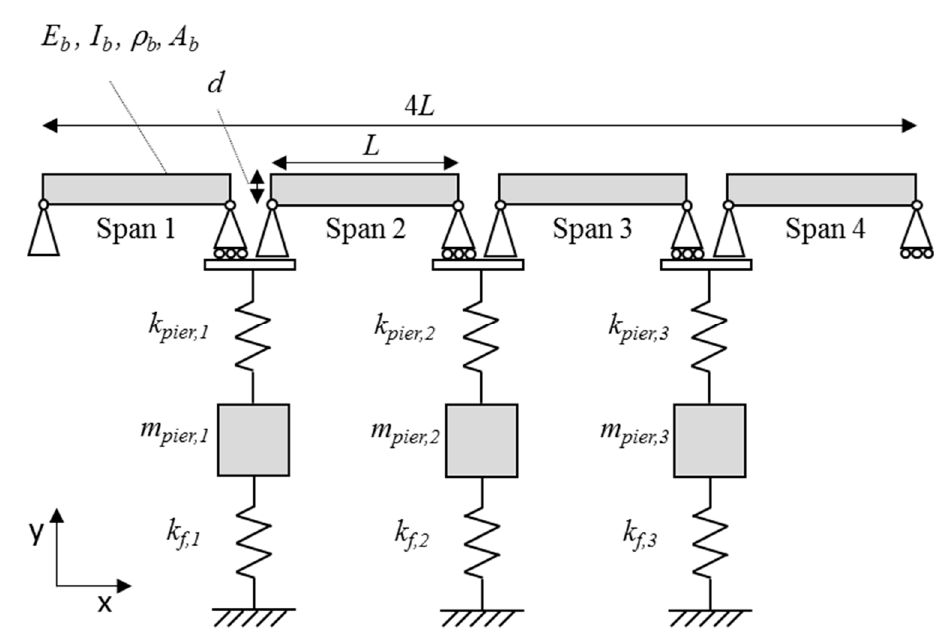
Figure 4. Numerical model schematic.